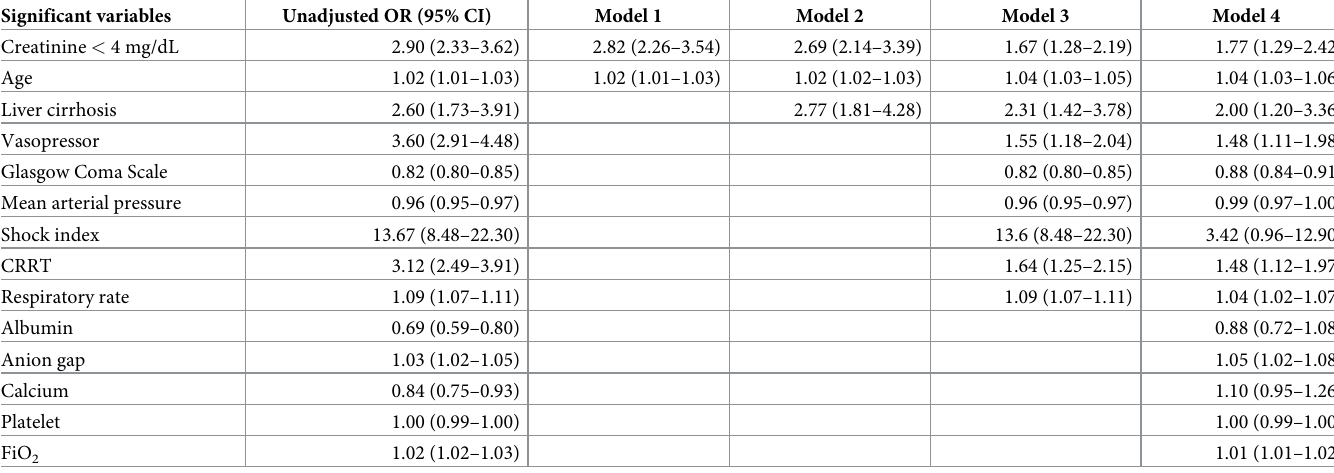
Table 2. Risk of mortality in low predialysis creatinine patients compared with high predialysis creatinine